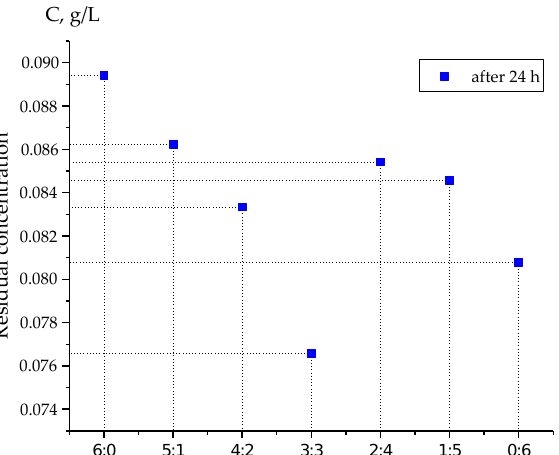
Figure 5. Atomic emission analysis of residual concentration of Ce ions in a solution after 24 h of sorption.